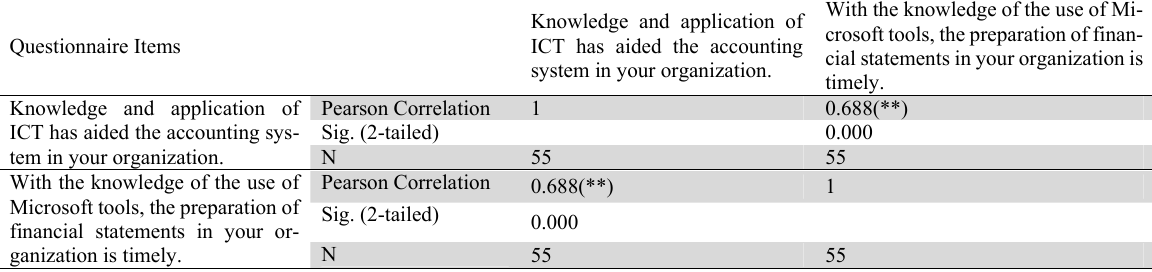
Correlation results of ICT knowledge and accounting system of SMEs